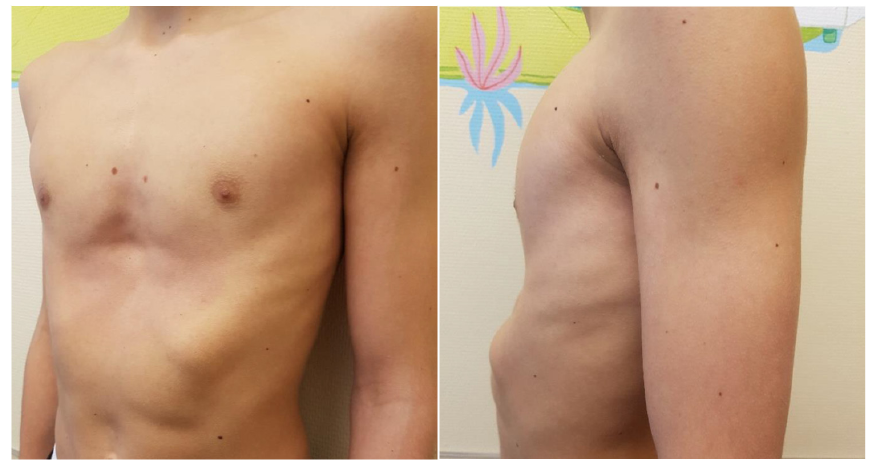
Figure 4. 17 years old male patient with PE and bilateral costal flaring, before MIRPE (Cross bar technique).